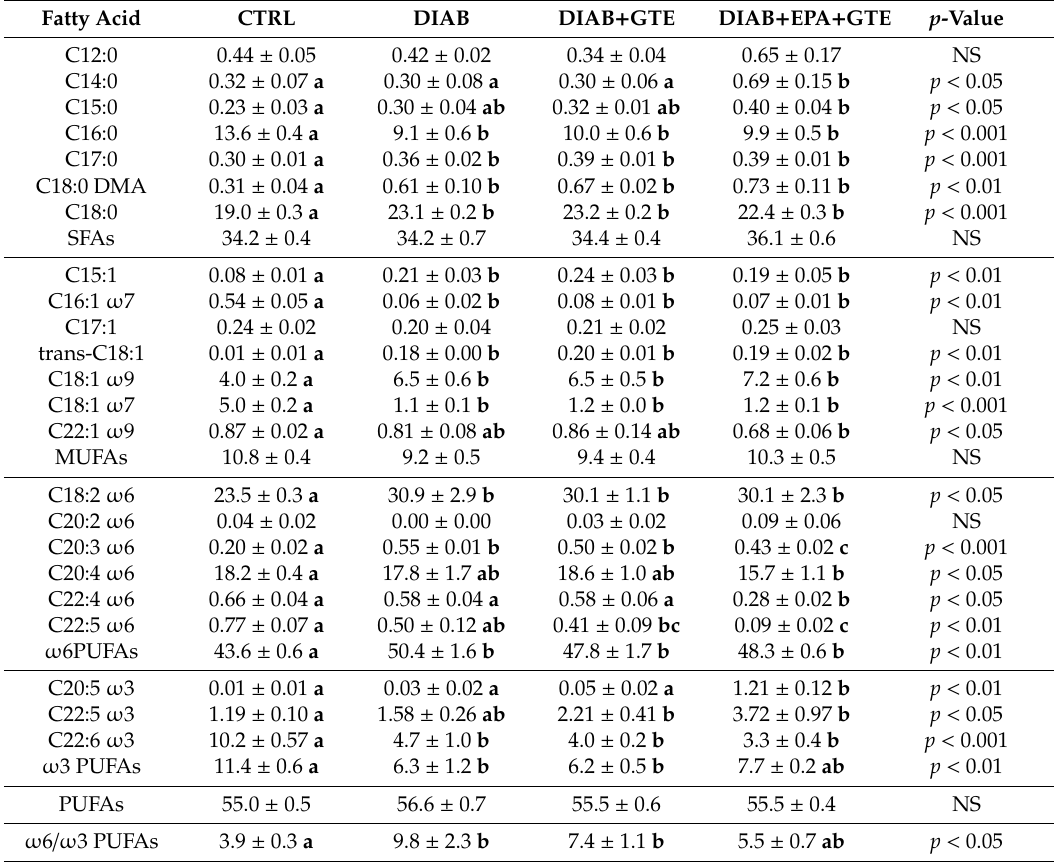
Table 3. Fatty acids composition of cardiac